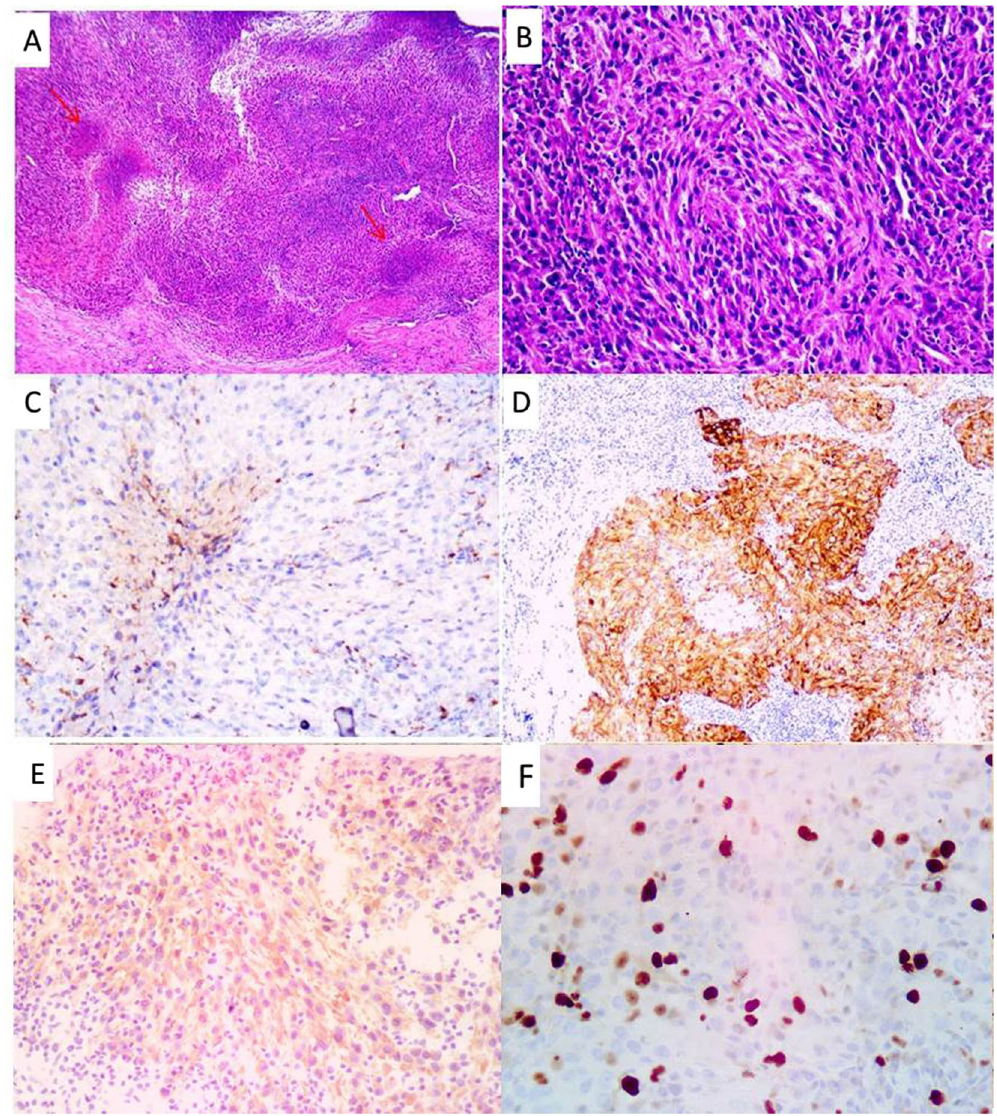
Figure 3. Histologic sections of case 2 displayed the sheets of atypia of epithelium-like cells and patchy necrosis (red arrow) ( A ). The tumor cells were spindle to oval, had abundant cytoplasm and prominentnucleoli ( B ). The tumor cells expressed CD68 ( C ), S100 ( D ), CKpan focal positive ( E ) and Ki-67 index 30% ( F